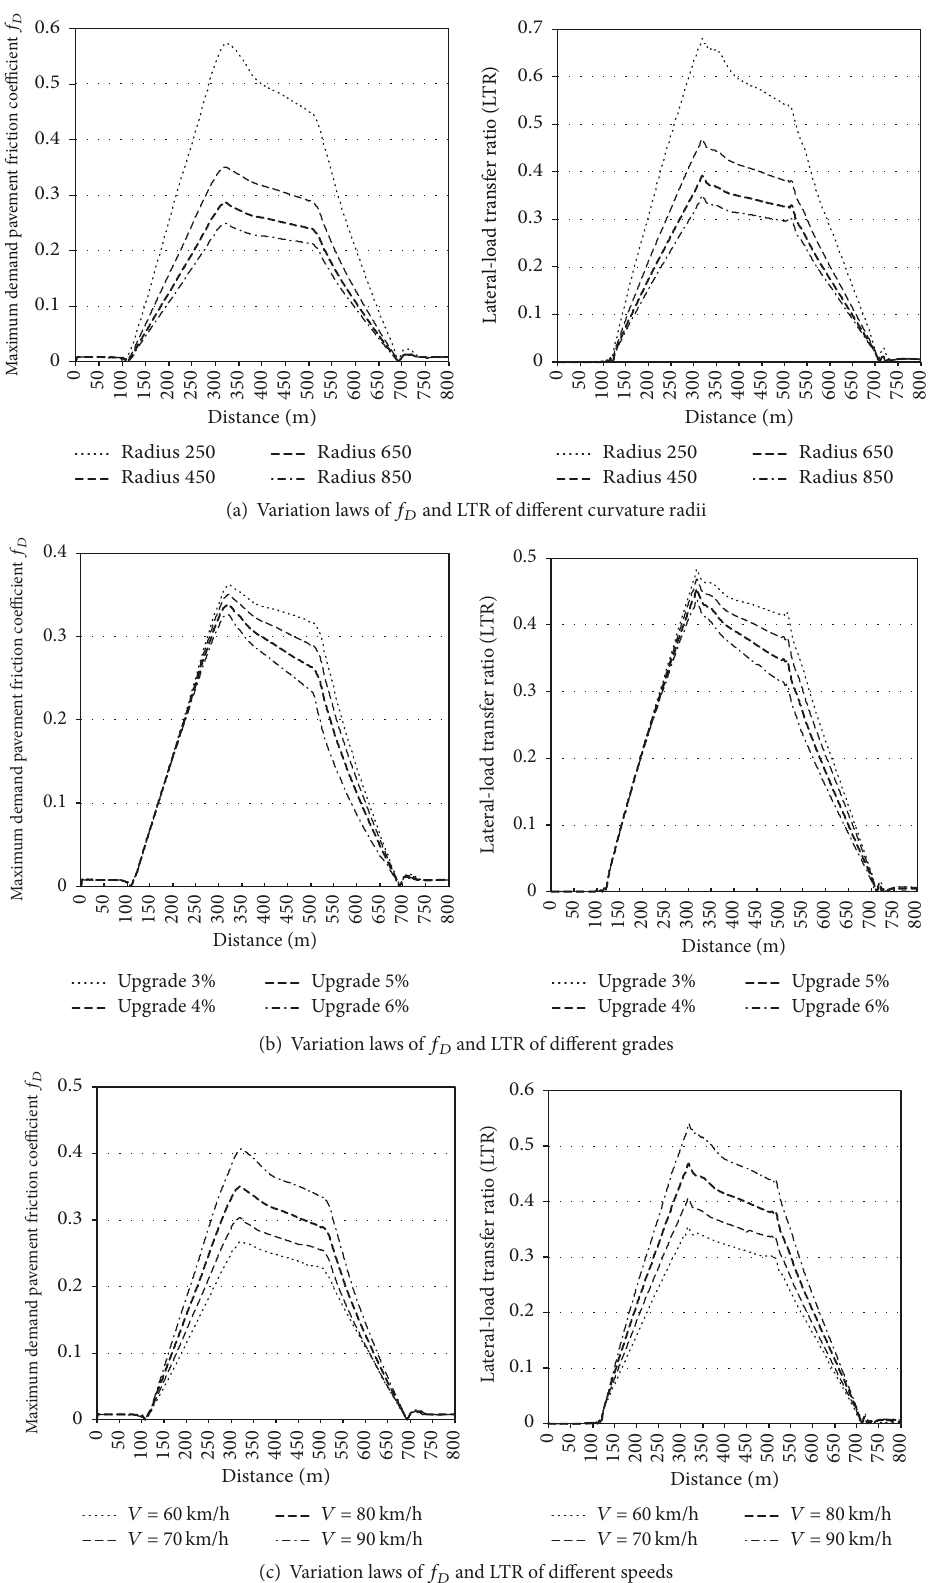
Figure 7: Variation laws of 𝑓 𝐷 and LTR on curved